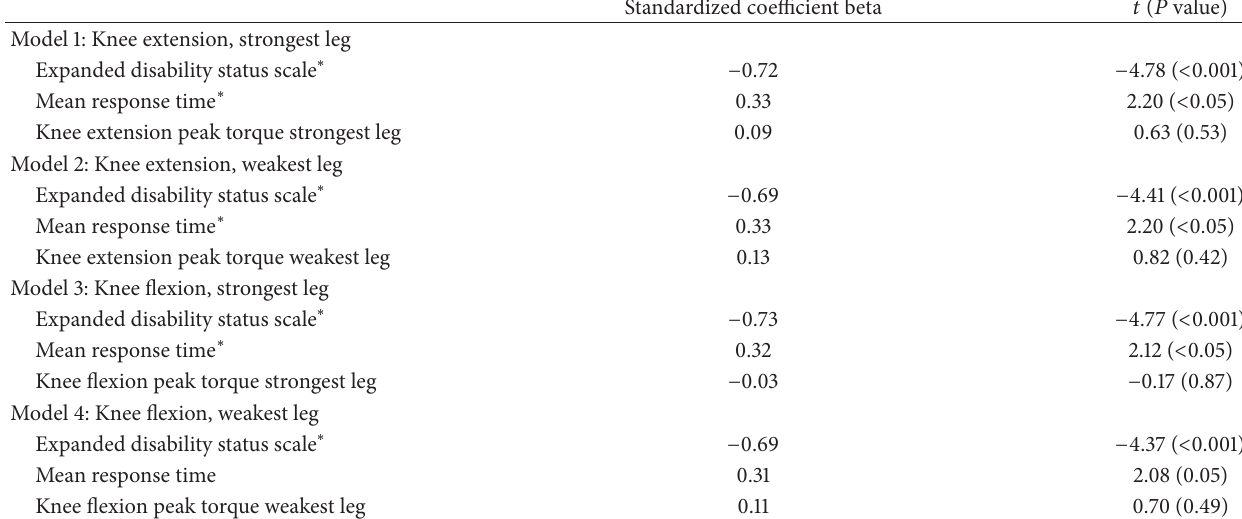
Table 3: Regression analyses for the prediction of 6-minute walking distance as a percentage of normal